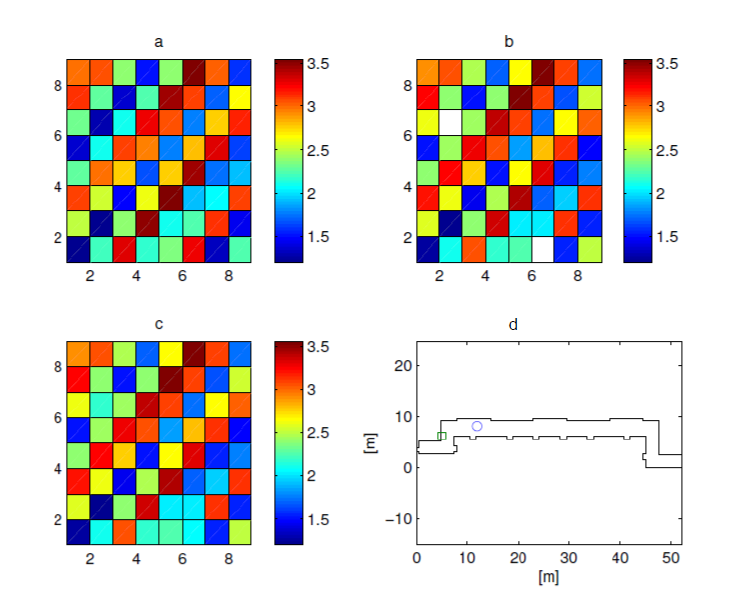
Figure 10. 9 × 9 MIMO system in a corridor; amplitude of the exact (noise-free) ( a ), measured ( b , c ) estimated ( c ) channel matrix; ( d ) geometry of the problem: the position of the transmitting and receiving MIMO systems are plotted as green square and blue circle respectively.